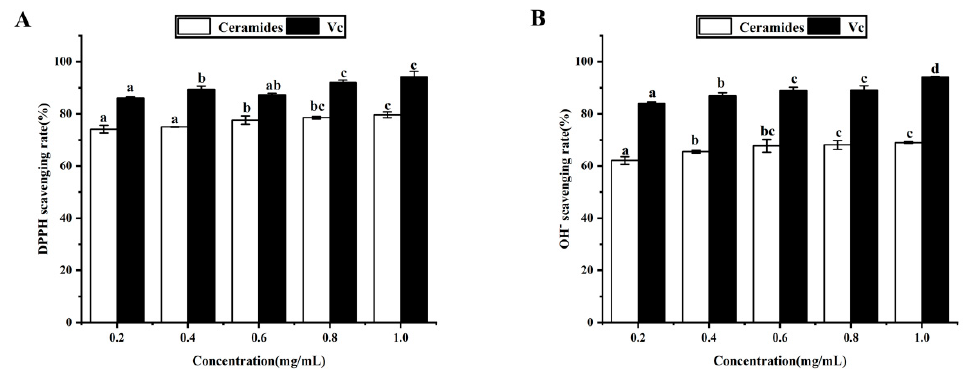
Figure 7. Effects of Cers on ( A ) DPPH and ( B ) hydroxyl free radical scavenging activity. Varying lowercase letters (a–d) indicate statistically significant differences ( p < 0.05). Vc indicates the aqueous solution of the vitamin C standard used as a positive control. Table 5. Antioxidant activity of purified Cers.